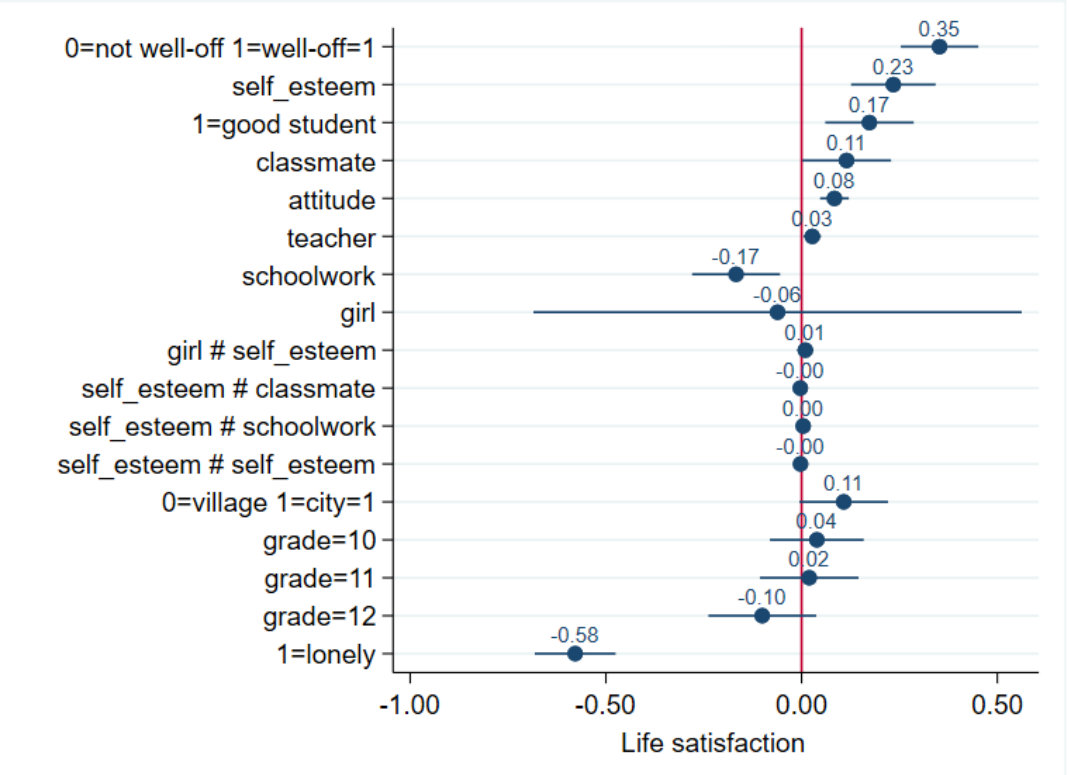
Figure 2. Coefficients with confidence intervals of the independent demographic and school-related psychosocial variables on life satisfaction in adolescents. # means interaction